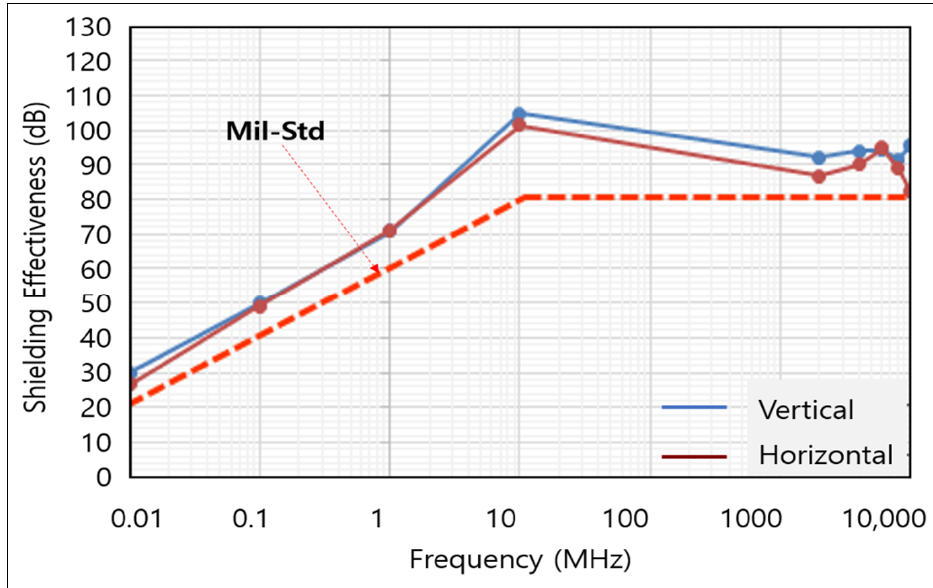
Figure 11. Shielding effectiveness of specimen #8 (W = 1000, orthogonal).